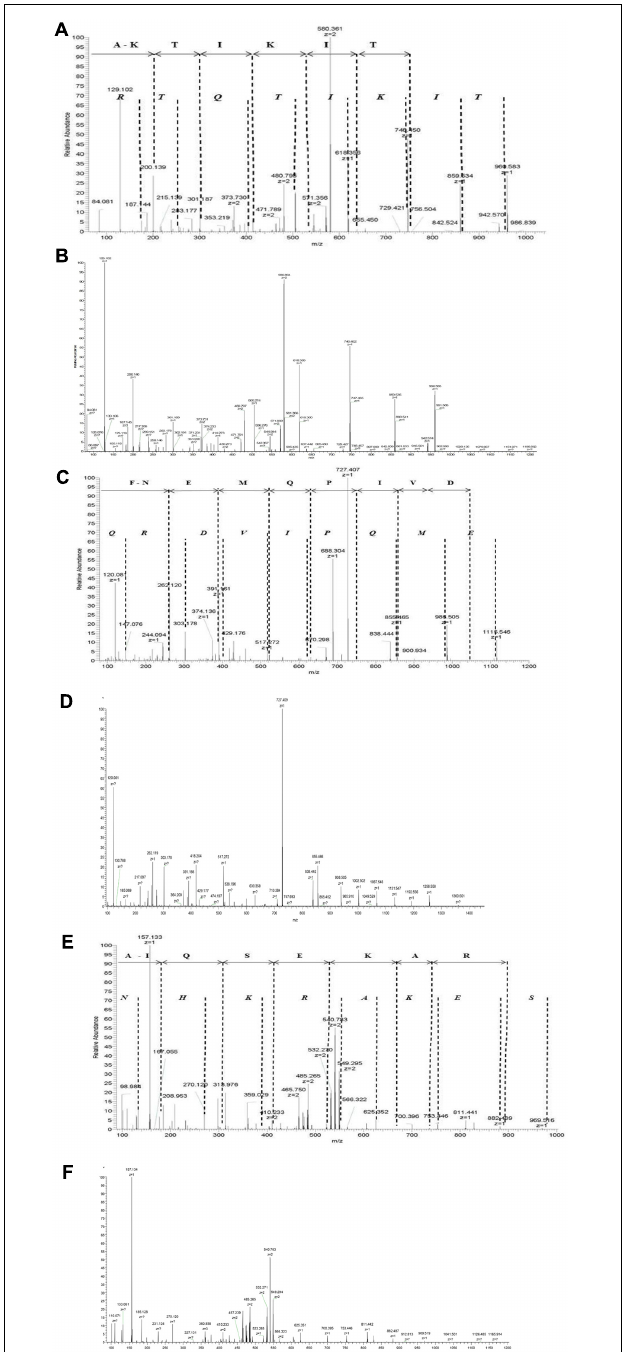
FIGURE 1 | Identification of AmiA peptide ligand AKTIKITQTR, AliA peptide ligand FNEMQPIVDRQ, and AliB peptide ligand AIQSEKARKHN. Manual interpretation of the fragment peaks is shown using non-italic letters for the b- ion (fragments appearing to extend from the N-terminal fragment) and italic letters for the y -ion. Representative fragment mass spectrum was confirmed for correct interpretation with fragment spectra of synthetic peptides (B, D, F) . (A) AmiA peptide ligand: extracted ion chromatogram of the doubly charged peptide ion with mass-to-charge ratio ( m / z ) of 580.361 [retention time (RT) 15.98 min]. The b -ion series (fragments appearing to extend from